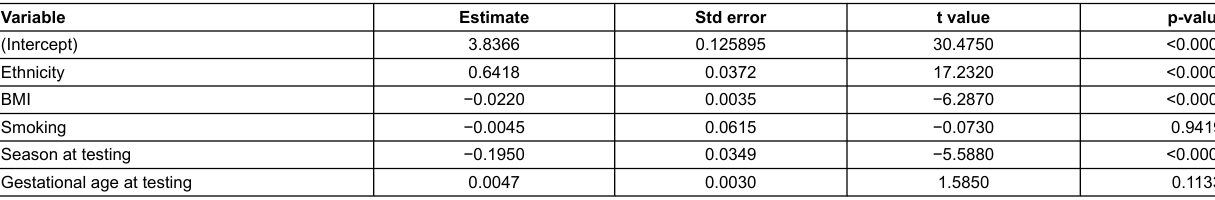
Table 3: Linear model for vitamin D status and risk factors * .